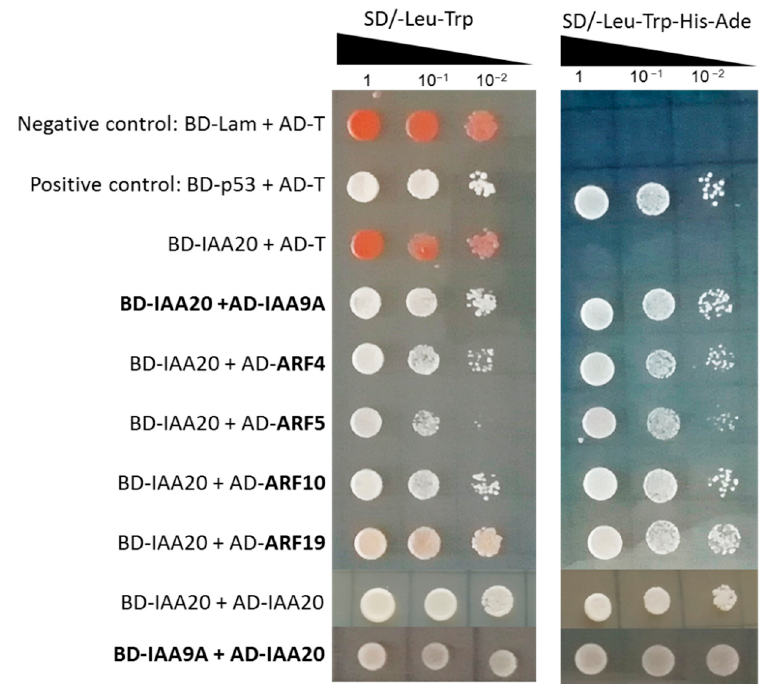
Figure 9. Yeast-two-hybrid analysis of protein interactions between EgrIAA20 and xylem expressing EgrARFs and EgrIAA proteins. The EgrIAA20 and EgrARF/EgrIAA proteins were fused with Gal4 DNA-binding domain (BD) and a GAL4 activation domain (AD), respectively. The interaction between BD-Lam and AD-T was used as negative control, while the interaction between BD-p53 and AD-T was used as positive control. Yeast cells were inoculated on selective medium in a 10-fold gradient dilution. SD/-Leu-Trp: double dropout medium lacking leucine and tryptophan; SD/-Leu- Trp-His-Ade: quadruple dropout medium lacking leucine, tryptophan, histidine, and adenine.